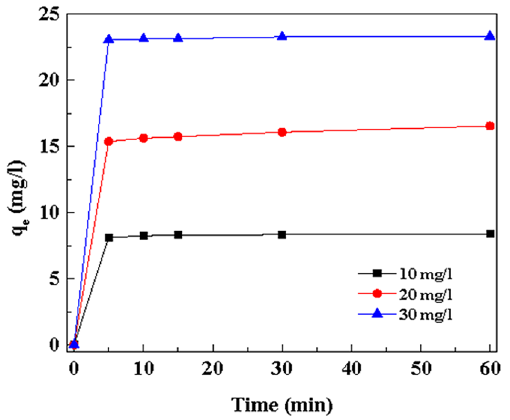
Figure 7. Effect of dye concentration and contact time on MB. Conditions: MB concentration: 10, 20 and 30 mg/L; Volume = 25 mL, Absorbent dose = 30 mg; Temp. = 30 ± 10 °C; Speed of agitation = 200 rpm; Contact time = 60